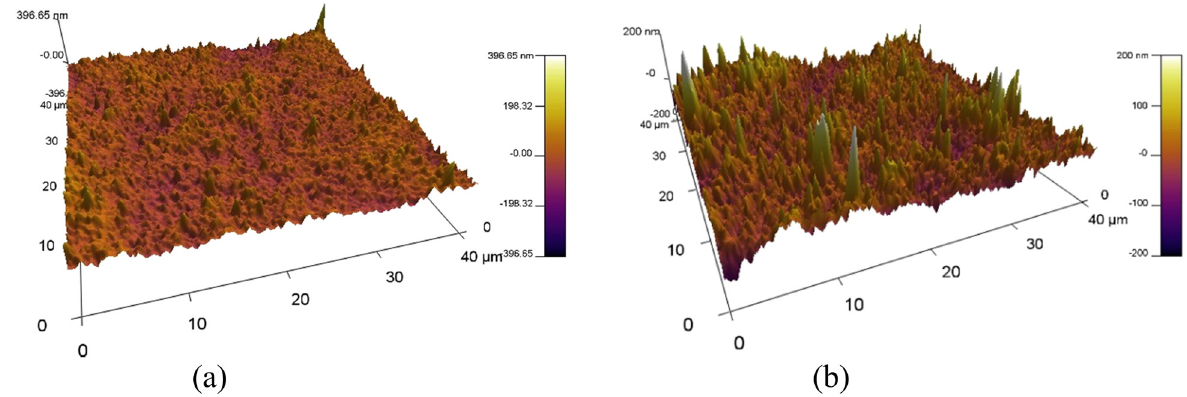
Figure 3: AFM 3D pro fi le of PEDOT:PSS coating: ( a ) non - textured and ( b ) textured during its growth on the SAW excited substrate.